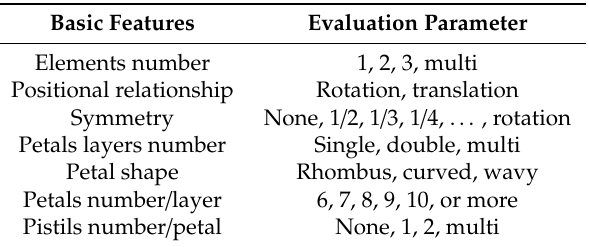
Table 1. Basic features of flower patterns.